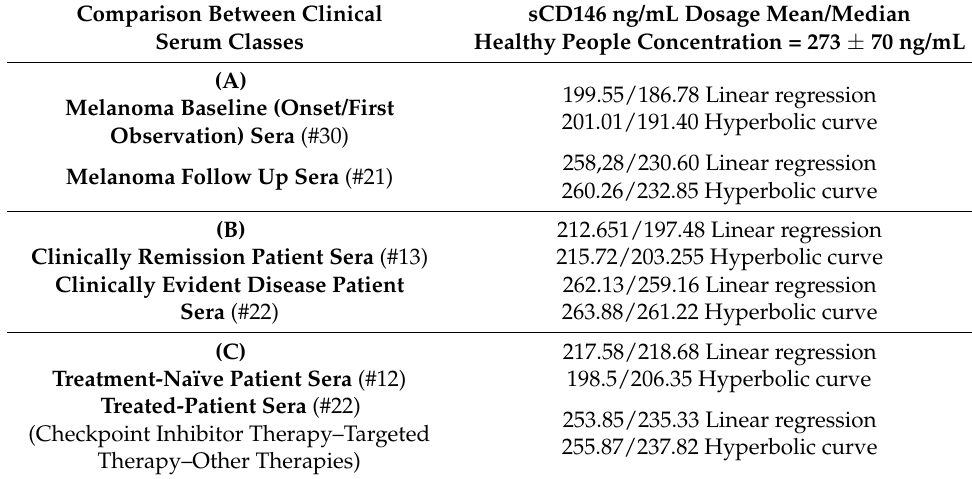
Table 5. Soluble CD146 (sCD146) serum dosages and